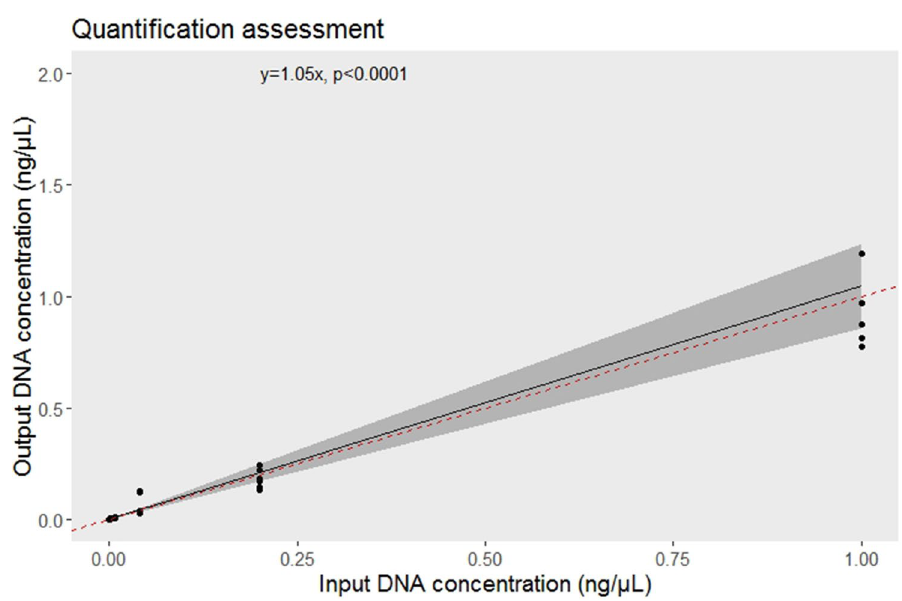
Figure 4. The relationship between the input and output DNA concentration. The grey band indicates the 95% confidence interval and the dotted red line represents a slope of